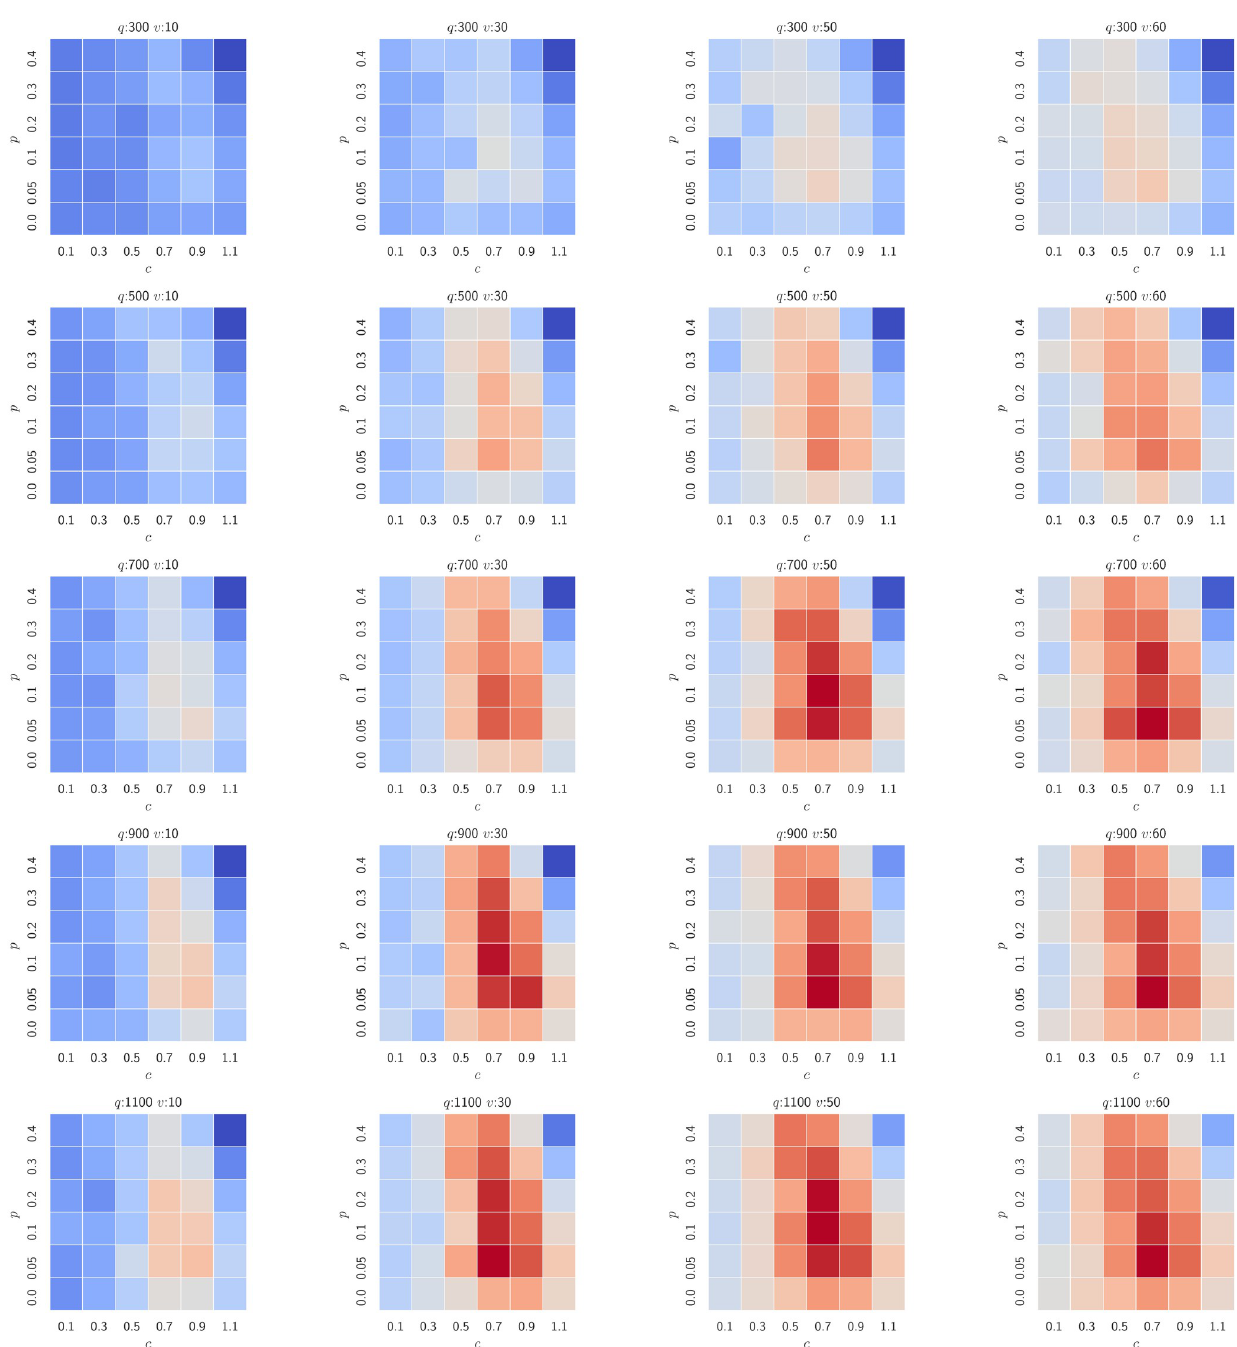
PLOS ONE | https://doi.org/10.1371/journal.pone.0269682 June 9,